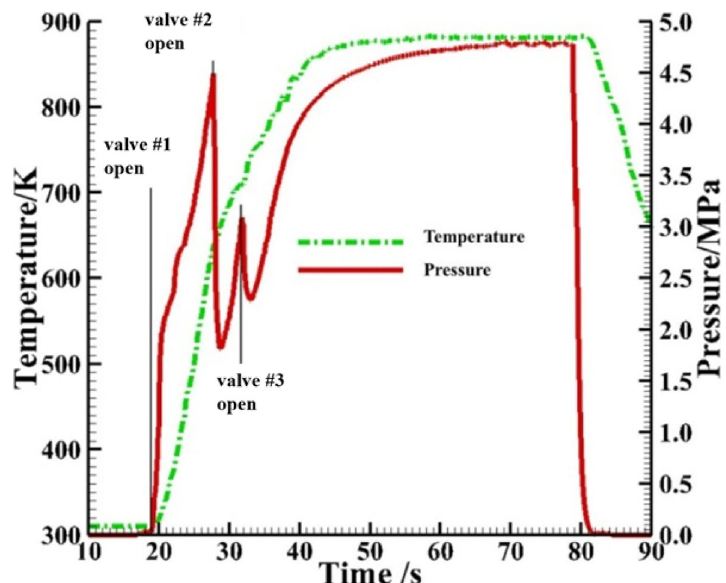
Fig. 9 Fluid temperature and pressure before the injecting holes and the opening of three valves